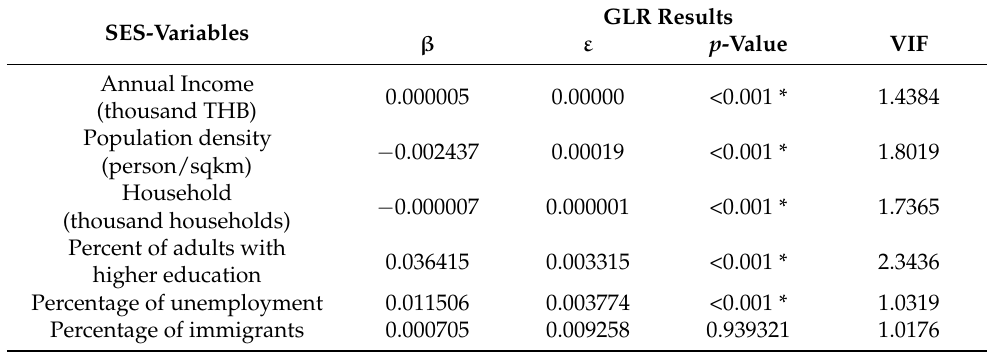
Table 4. Results of the GLR analysis of the relationship between the SES variables and childhood obesity.